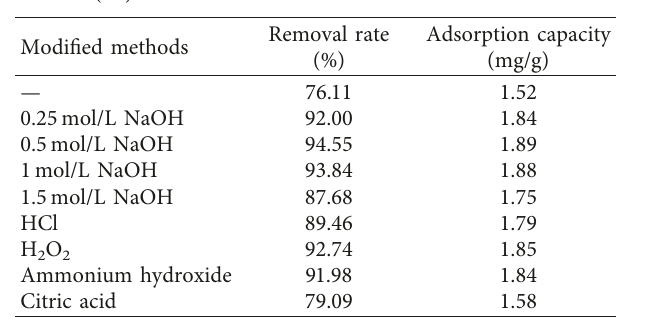
Table 1: Effect of modified materials on adsorption of uranium(VI).